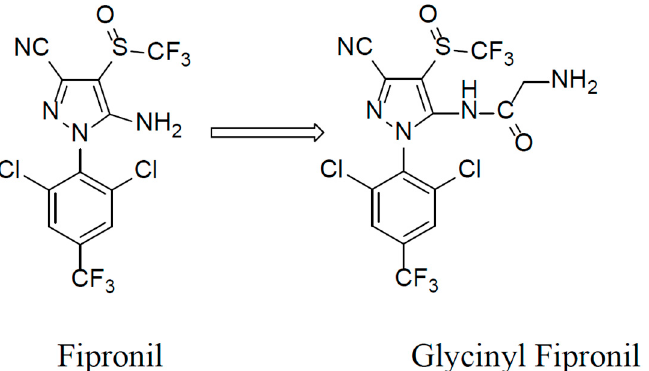
Figure 3. Xu et al.’s Introduction of a glycinyl group to the 5-amine moiety of fipronil, which improves the phloem’s systematicity.